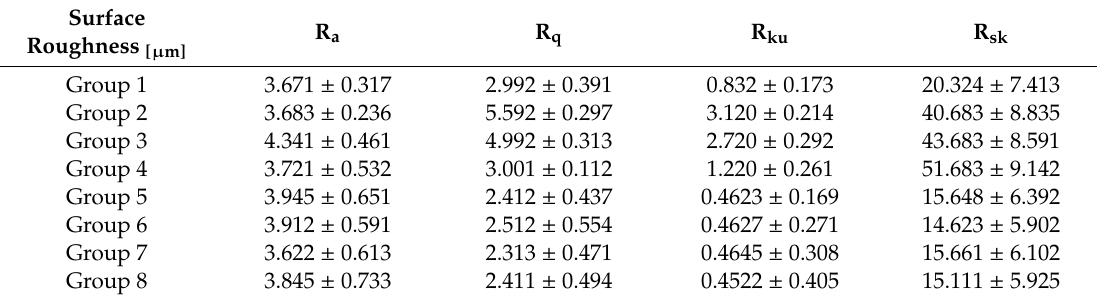
Table 2. Summary of the surface roughness parameters of the study